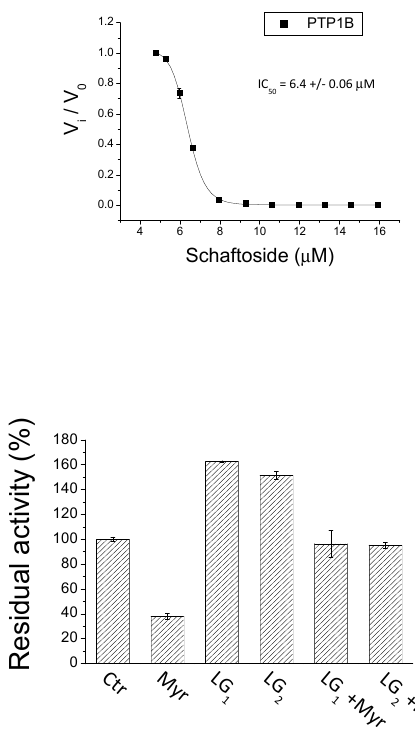
Figure 5. ( a ) IC 50 of schaftoside. ( b ) Residual activity of PTP1B enzyme (in vitro %) of: Ctrl for control (see experimental section), myricetin standard (Myr), Lisosan ® G extracts alone (LG 1 –LG 2 ), and added with myricetin (LG 1 +Myr; LG 2 +Myr). The extracts were tested at 10 µ L/mL corresponding to 0.5 µ M for myricetin and 1.25 mg/mL for Lisosan ® G